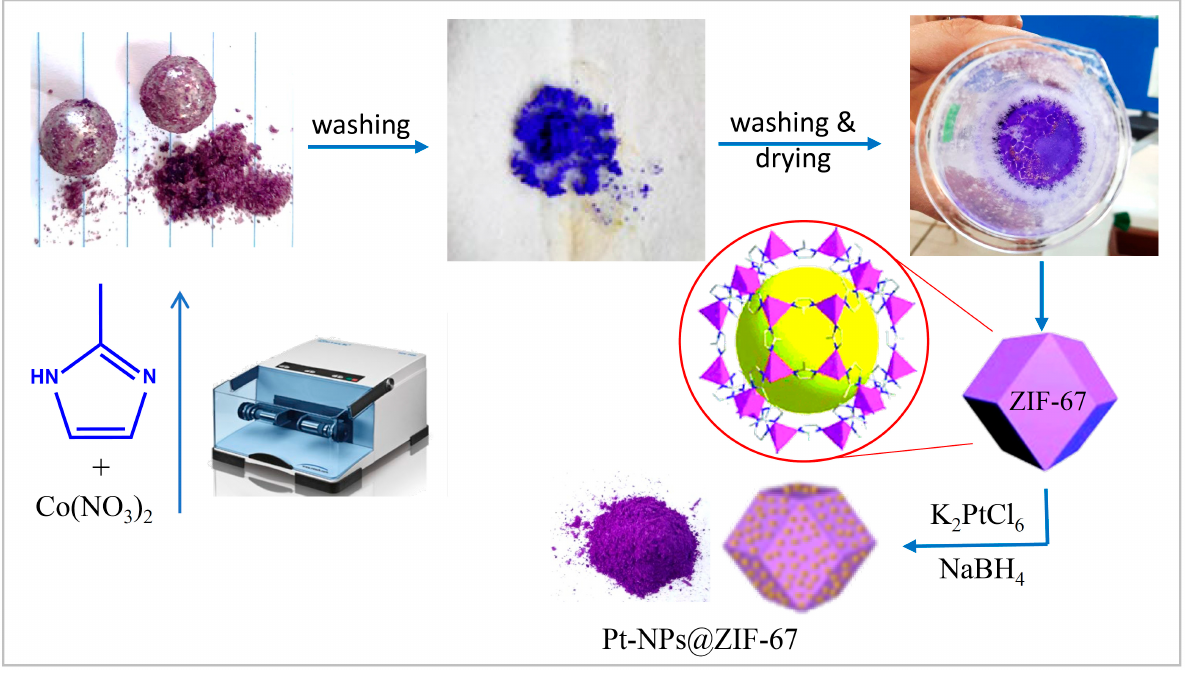
Figure 1. Schematic BM mediated synthesis of Pt@ZIF-67.